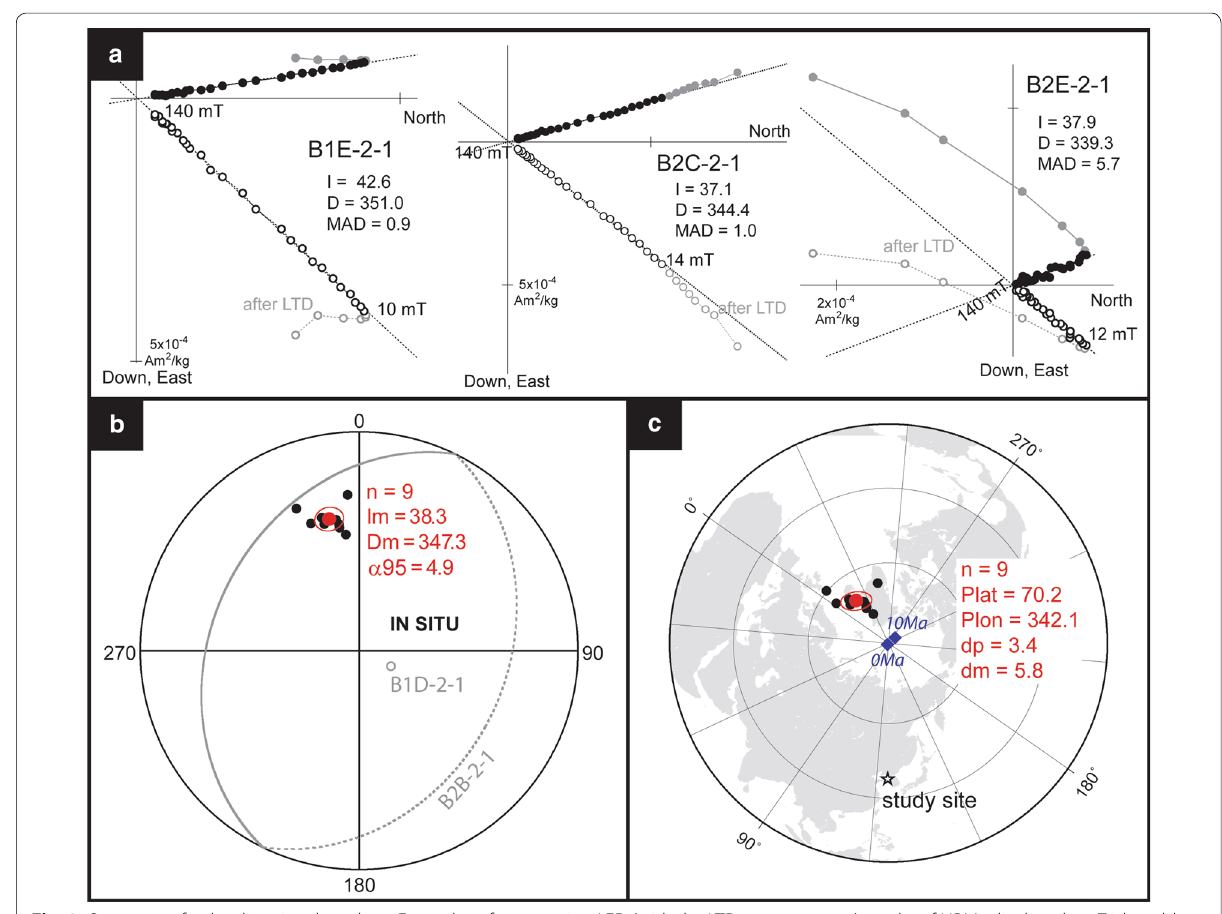
Fig. 3 Summary of paleodirectional results. a Examples of progressive AFD (with the LTD pre‑treatment) results of NRMs displayed on Zijderveld diagrams with geographic coordinate system. Determination of a ChRM direction from the PCA (Kirschvink 1980) is shown in each Zijderveld diagram. b Equal‑area projection of ChRM directions from 11 specimens for two sites, with an overall mean of the ChRMs and its 95% confidence limit (shown in red). Grey‑colored data represent data excluded in calculating the overall mean. Note that, for specimen B2B‑2‑1, a great circle fit by the technique of Halls (1976, 1978) is shown. c VGP positions calculated from the ChRM direction data used in the ChRM mean determination (see Fig. 3b) on the northern hemisphere, with their mean and the corresponding 95% confidence limit (shown in red). For reference, synthetic poles for East Asia at 0 and 10 Ma suggested by Cogné et al. (2013) are shown as diamonds. Location of the studied area is shown as a star